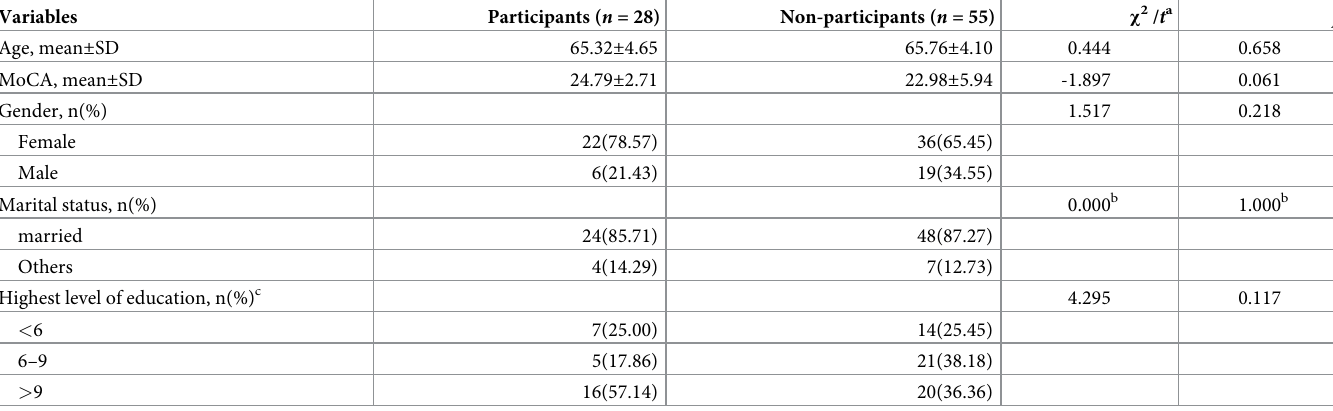
Table 2. Basic information of the 83 older adults attracted by the program publicity activity.